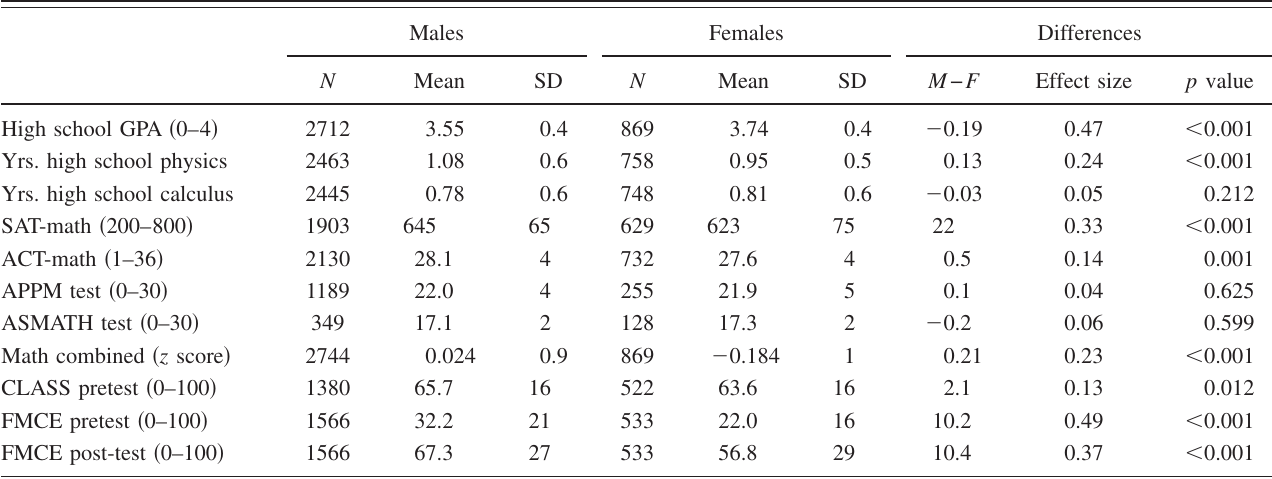
TABLE IV. Male and female average values for all background variables that were collected. The range of possible scores for each variable is shown in parentheses. The effect size is calculated as ES= (cid:1)(cid:5) S (cid:6) M − (cid:5) S (cid:6) F (cid:2) / SD, where the SD for all students is used. Significant differences exist between males and females on almost all of the background variables.